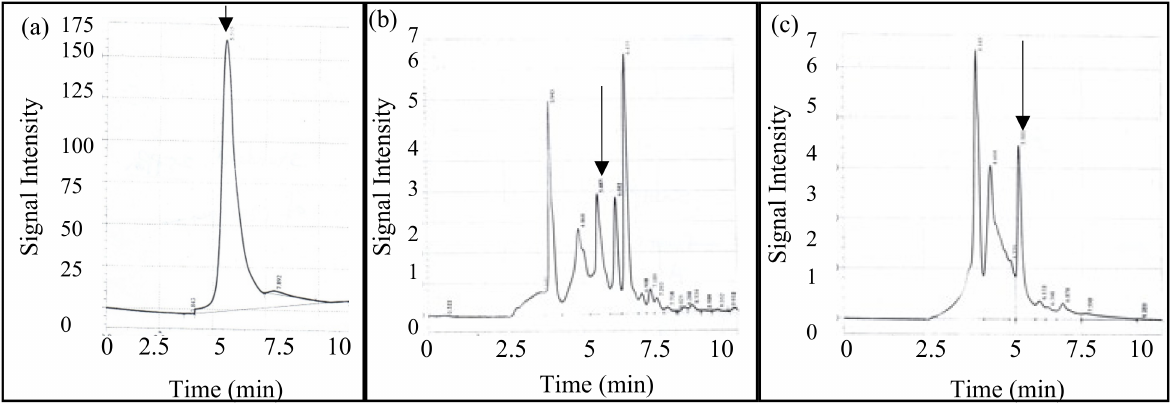
Figure 4. High-performance liquid chromatography of collagen ( a ) type I collagen; ( b ) pepsin- solubilized catfish skin; ( c ) acid-solubilized catfish skin. The arrow indicates a retention time of 5.5